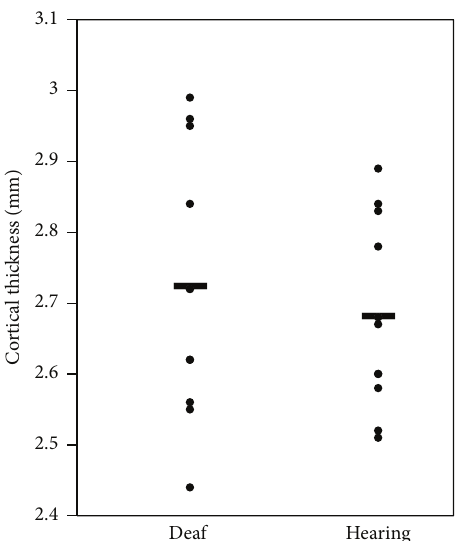
Figure 4: Mean cortical thickness of the right hemisphere planum temporale region. Horizontal bars indicate group means. Cortical thickness in the deaf group was not different from a hearing group matched for age and gender, taken from Shiell et al. (2014)